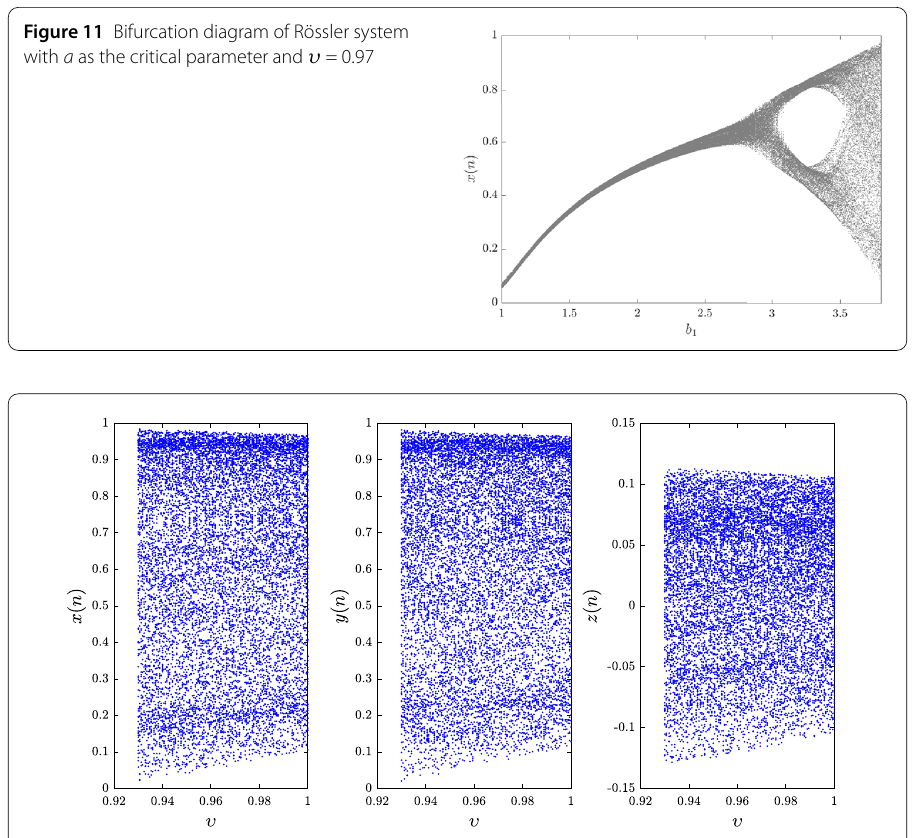
Figure 12 Bifurcation diagram of the fractional Rössler map with υ ∈ [0,1] as the critical parameter, ( b 2 , b 3 , b 4 , b 5 , b 6 , b 7 ) = (0.05,0.35,3.78,0.2,0.1,1.9) and ( x (0), y (0), z (0)) = (0.1,0.2,–0.5)